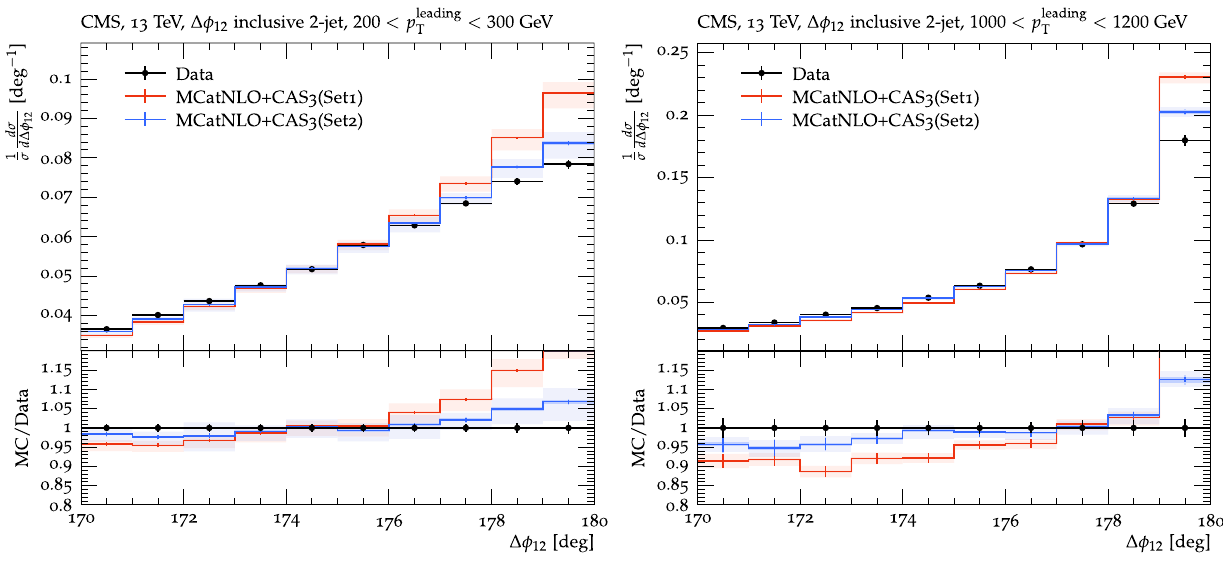
Fig. 7 Azimuthal correlation (cid:2)φ 12 in the back-to-back region for Shown are the uncertainties coming from the scale variation (as > 200 GeV (left) and p leading > 1000 GeV (right) as mea- described in the text) as well as the uncertainties coming from the p leading T T sured by CMS [27] compared with predictions from MCatNLO+CAS3.